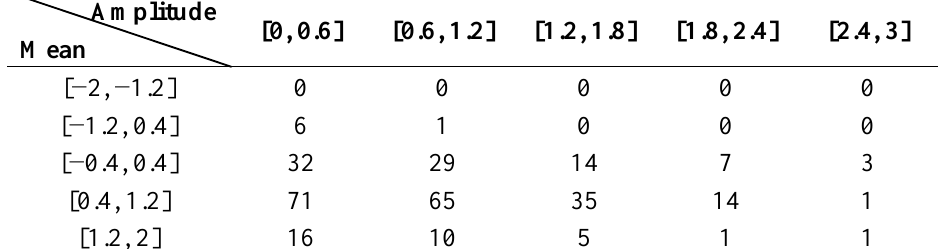
Table 1. Rain-flow matrix for cycle counting.